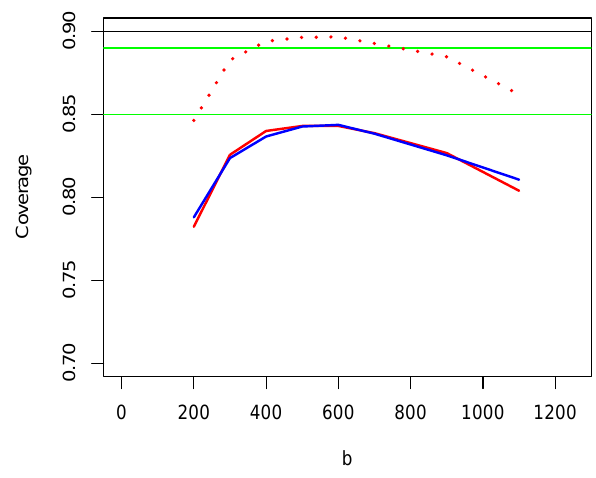
Fig. 5. Actual coverage probabilities of 90% subsampling SCBs for the trend in model ( 9) at a = 0 (solid red curve), a = 0 . 2 (blue curve), and for a calibrated SCB at a = 0 (dotted red curve). Hori- zontal green lines denote 0.85 and 0.89